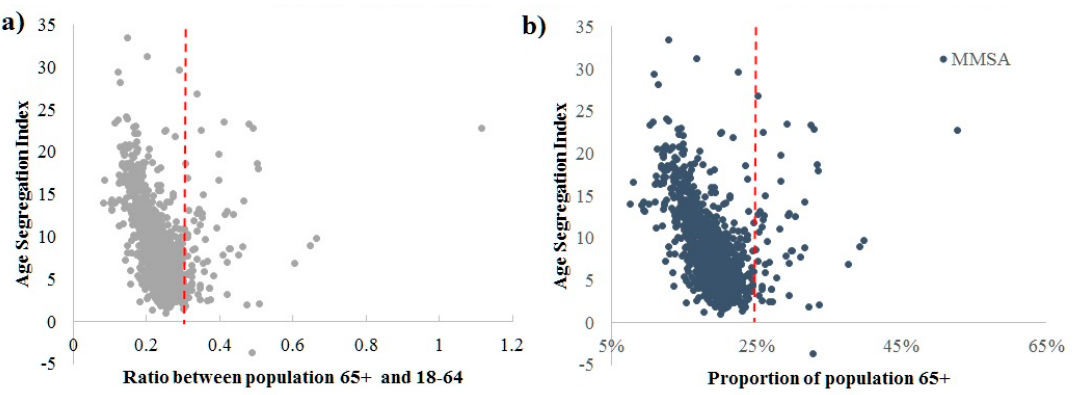
Figure 4. Comparison and correlation between the age segregation index and the age composition index, that is, the age segregation index versus ( a ) the ratio between seniors and adults; and ( b ) the proportion of senior people.